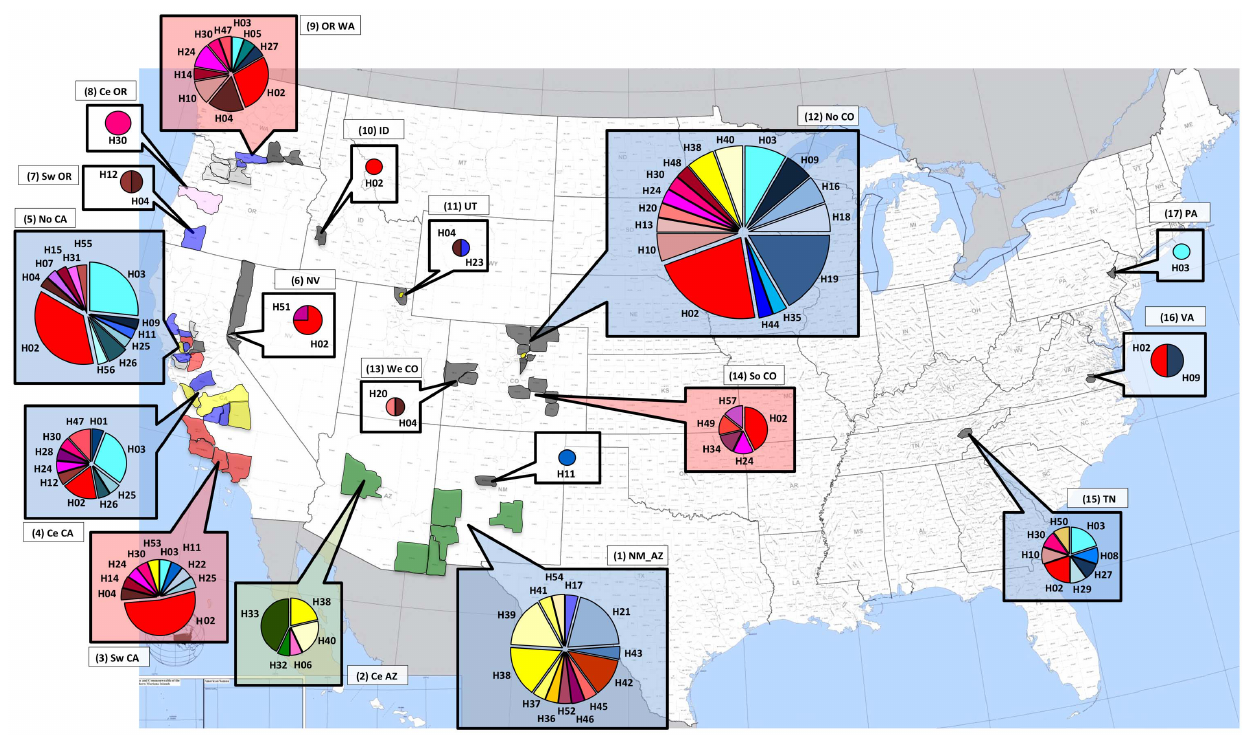
Figure 3. Distribution of 57 MLST-based Geosmithiamorbida haplotypes in the United States. The size of wedges in each pie chart is proportional to the number of isolates. Haplotype colors relate to genetic clusters identified in the four-cluster-MLST-DAPC model where cluster 1=shades of blue, cluster 2=shades of red/brown, cluster 3=shades of yellow, and cluster 4=shades of green. Callouts are color-coded according to the three-region geographic-Hudson’s Permtest model, where: 1) blue=NM_AZ, central CA, northern CA, northern CO, and TN; 2) green=central AZ; and 3) red=southwestern CA, OR_WA, and southern CO. Callouts in white indicate regions not assessed by using Hudson’s Permtest. Counties are color-coded as in Figure 1B. (U.S. map adapted from US Census Bureau at